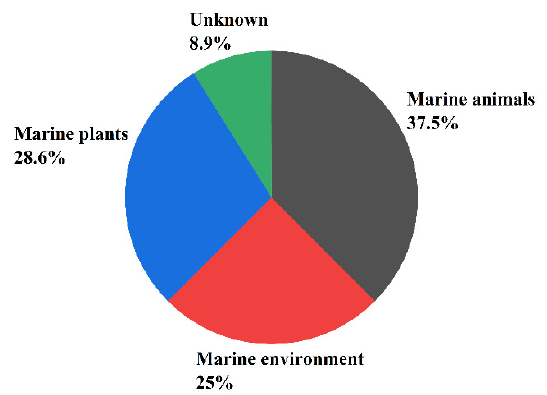
Figure 1. The main sources of the sesquiterpene-rich marine fungi.